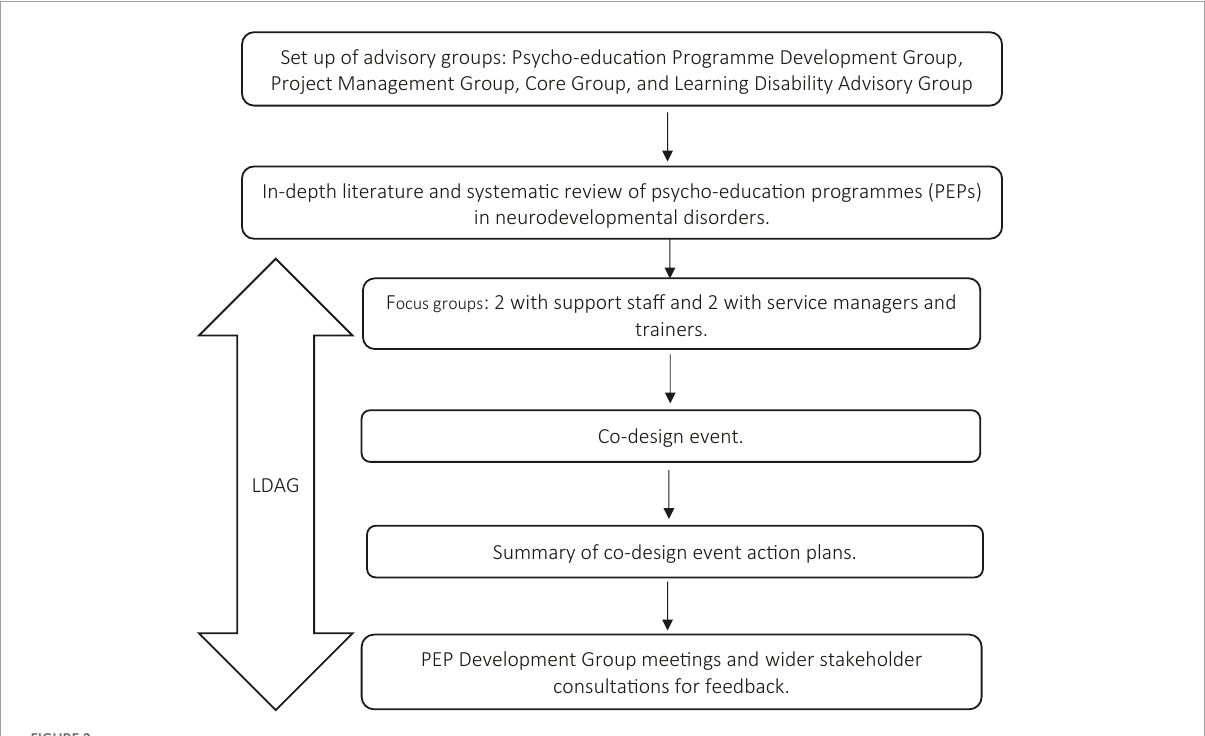
FIGURE2 Modified Experience Based Co-Design (EBCD) methodology for the development of SPECTROM